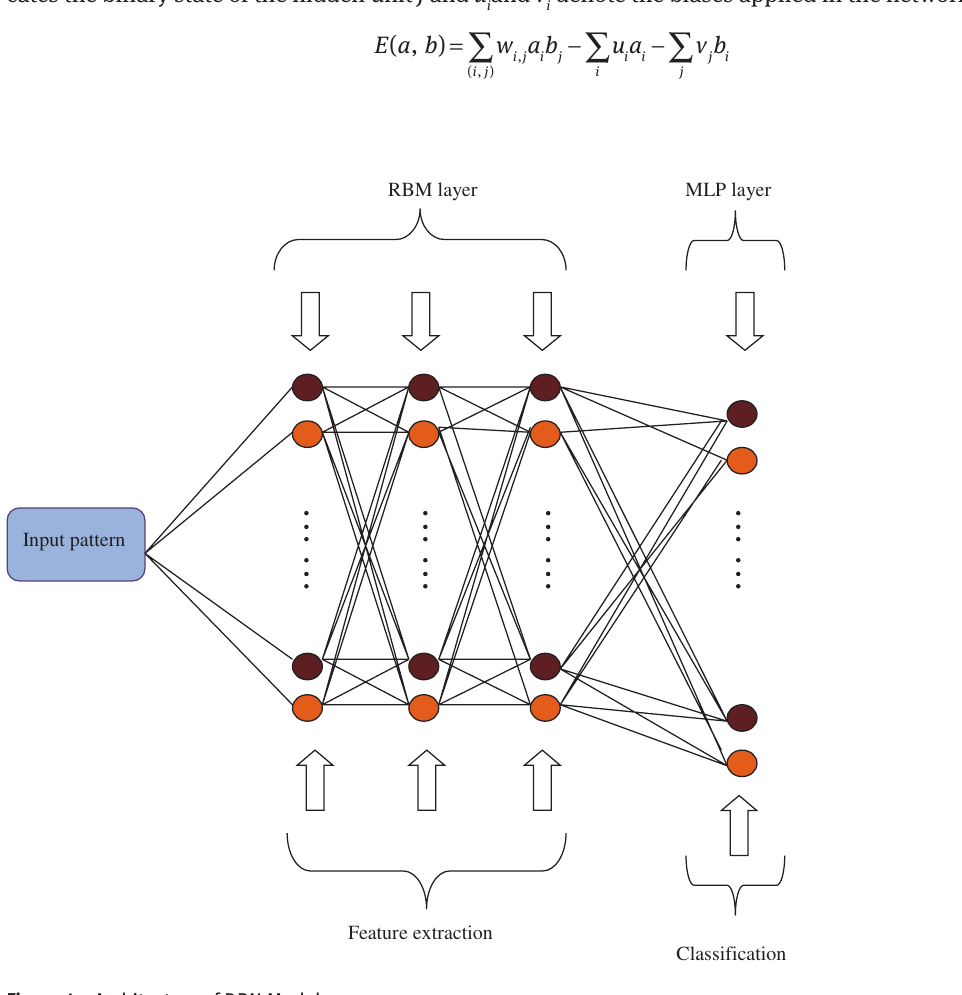
Figure 4: Architecture of DBN